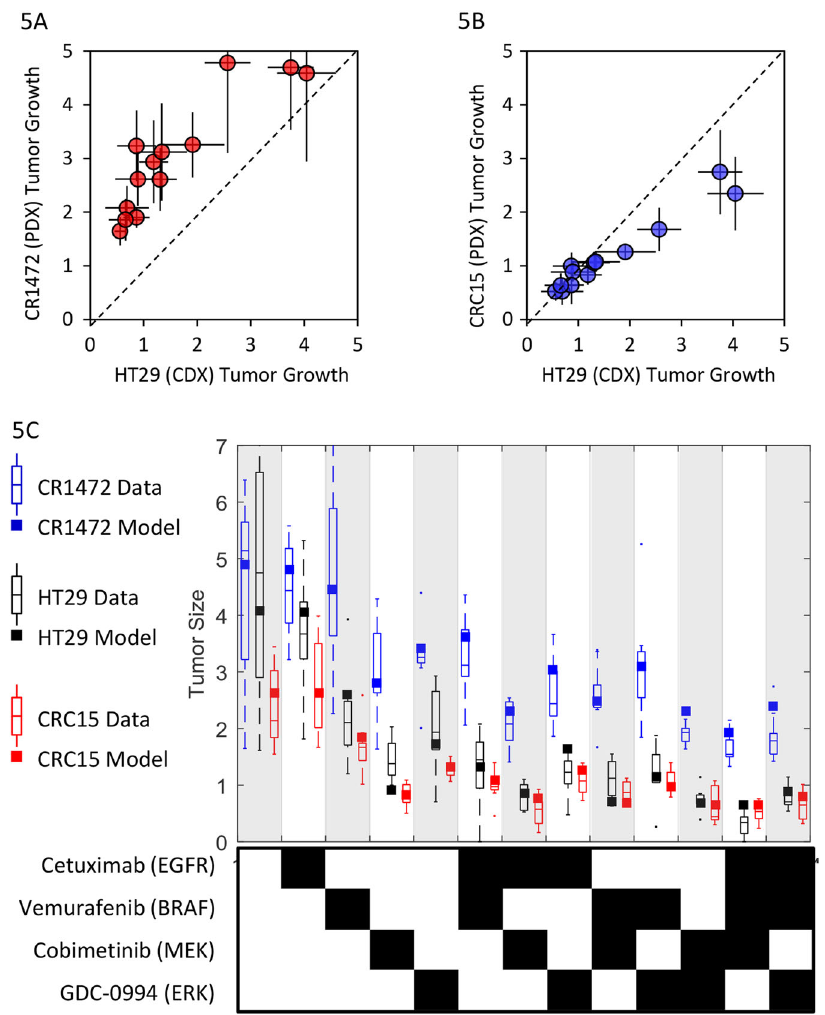
Fig. 5 Tumor growth and treatment responses in HT29 cell-line derived xenografts vs. two PDX models, CR1472 and CRC15. a HT29 vs. CR1472 and b HT29 vs. CRC15 tumor growth over 21-days on 13 alternate treatments. c Model simulations and experimental observations of changes in tumor size over 21-days for the 13